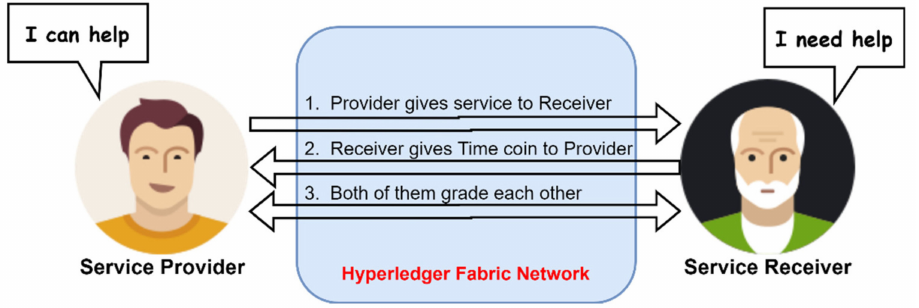
Figure 1. Basic processing steps of the proposed time bank system.